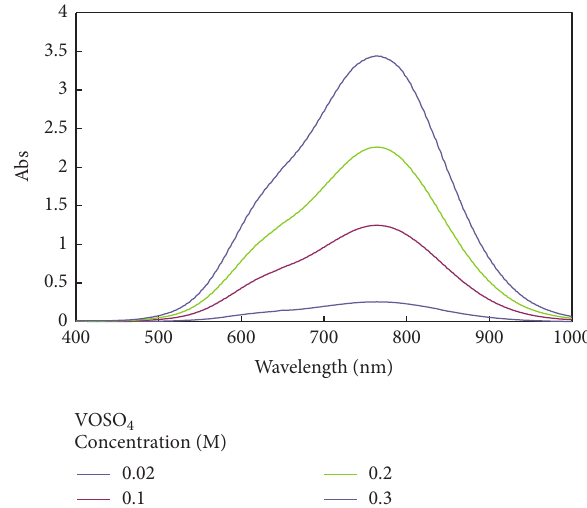
Figure 2: Absorption spectra of VOSO 4 solution for four different = 766 nm. concentrations at 𝜆 max